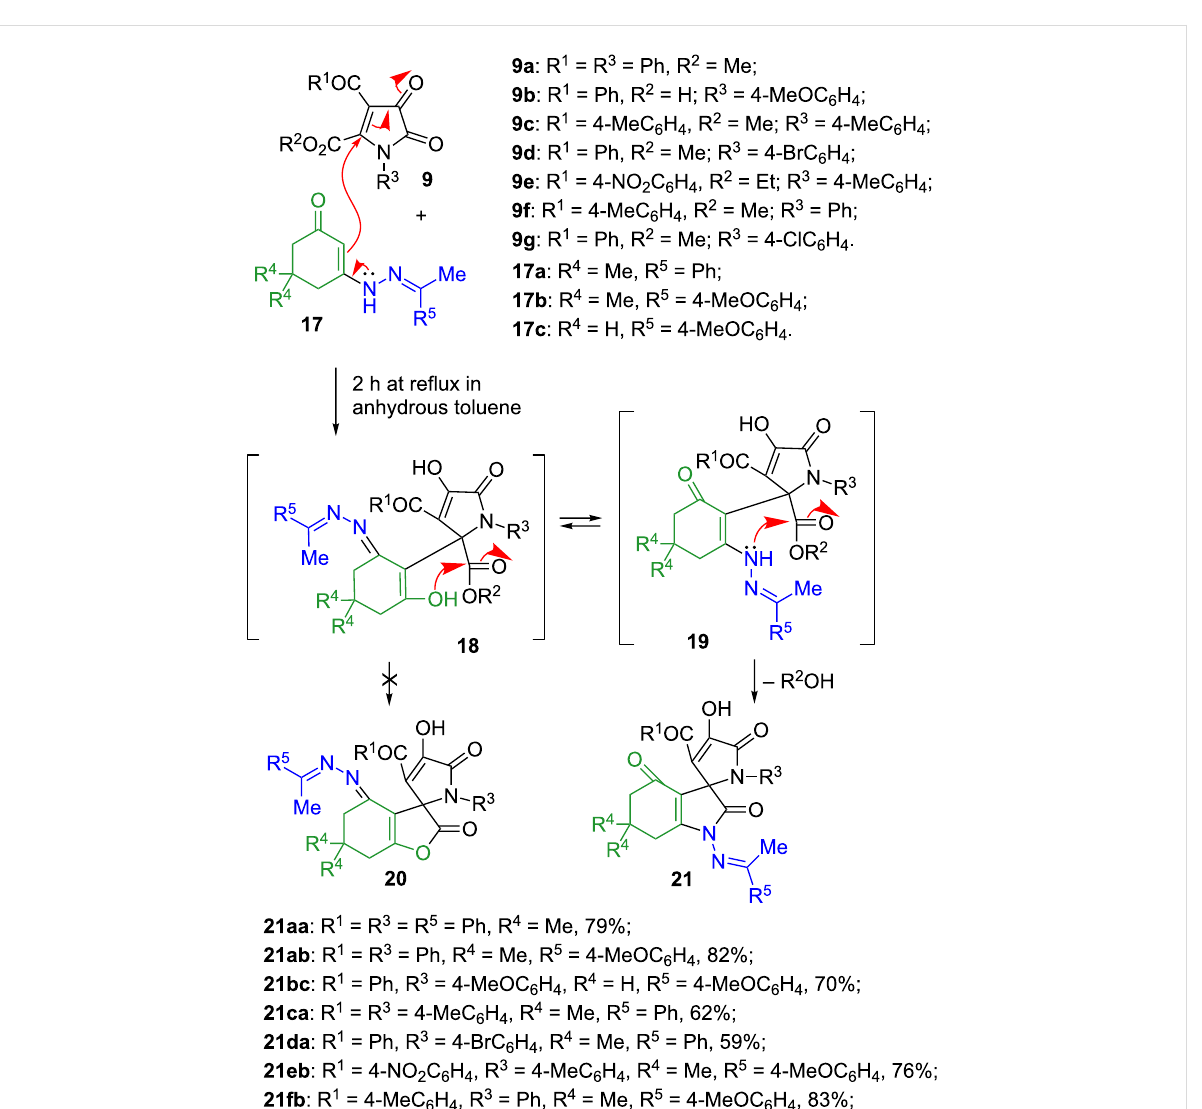
Scheme 5: Spirocyclizations involving non-bulky ketazinones 17 and 5-alkoxycarbonyl-1 H -pyrrolediones 9 .